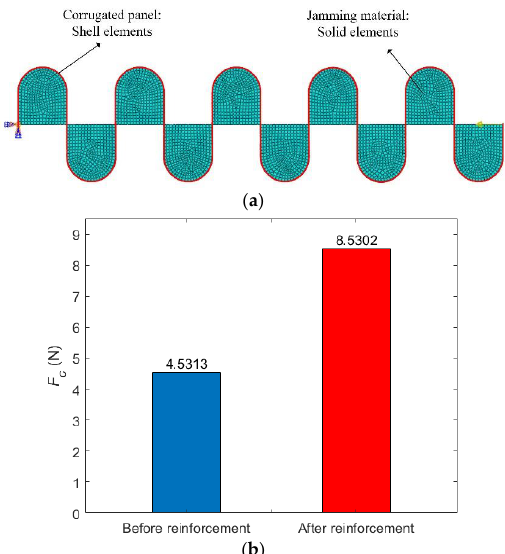
Figure 10. ( a ) Finite element model of the reinforced corrugated panel, ( b ) effect of the jamming material on the critical buckling loads.